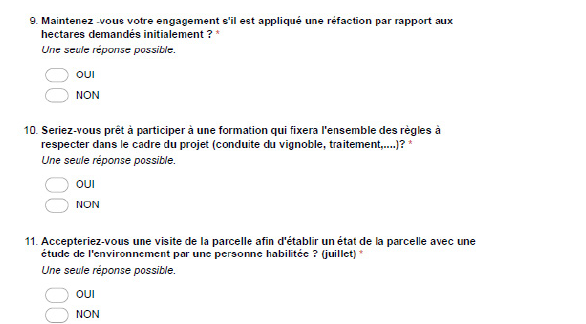
Figure 1: three questions among the thirty six questions of the